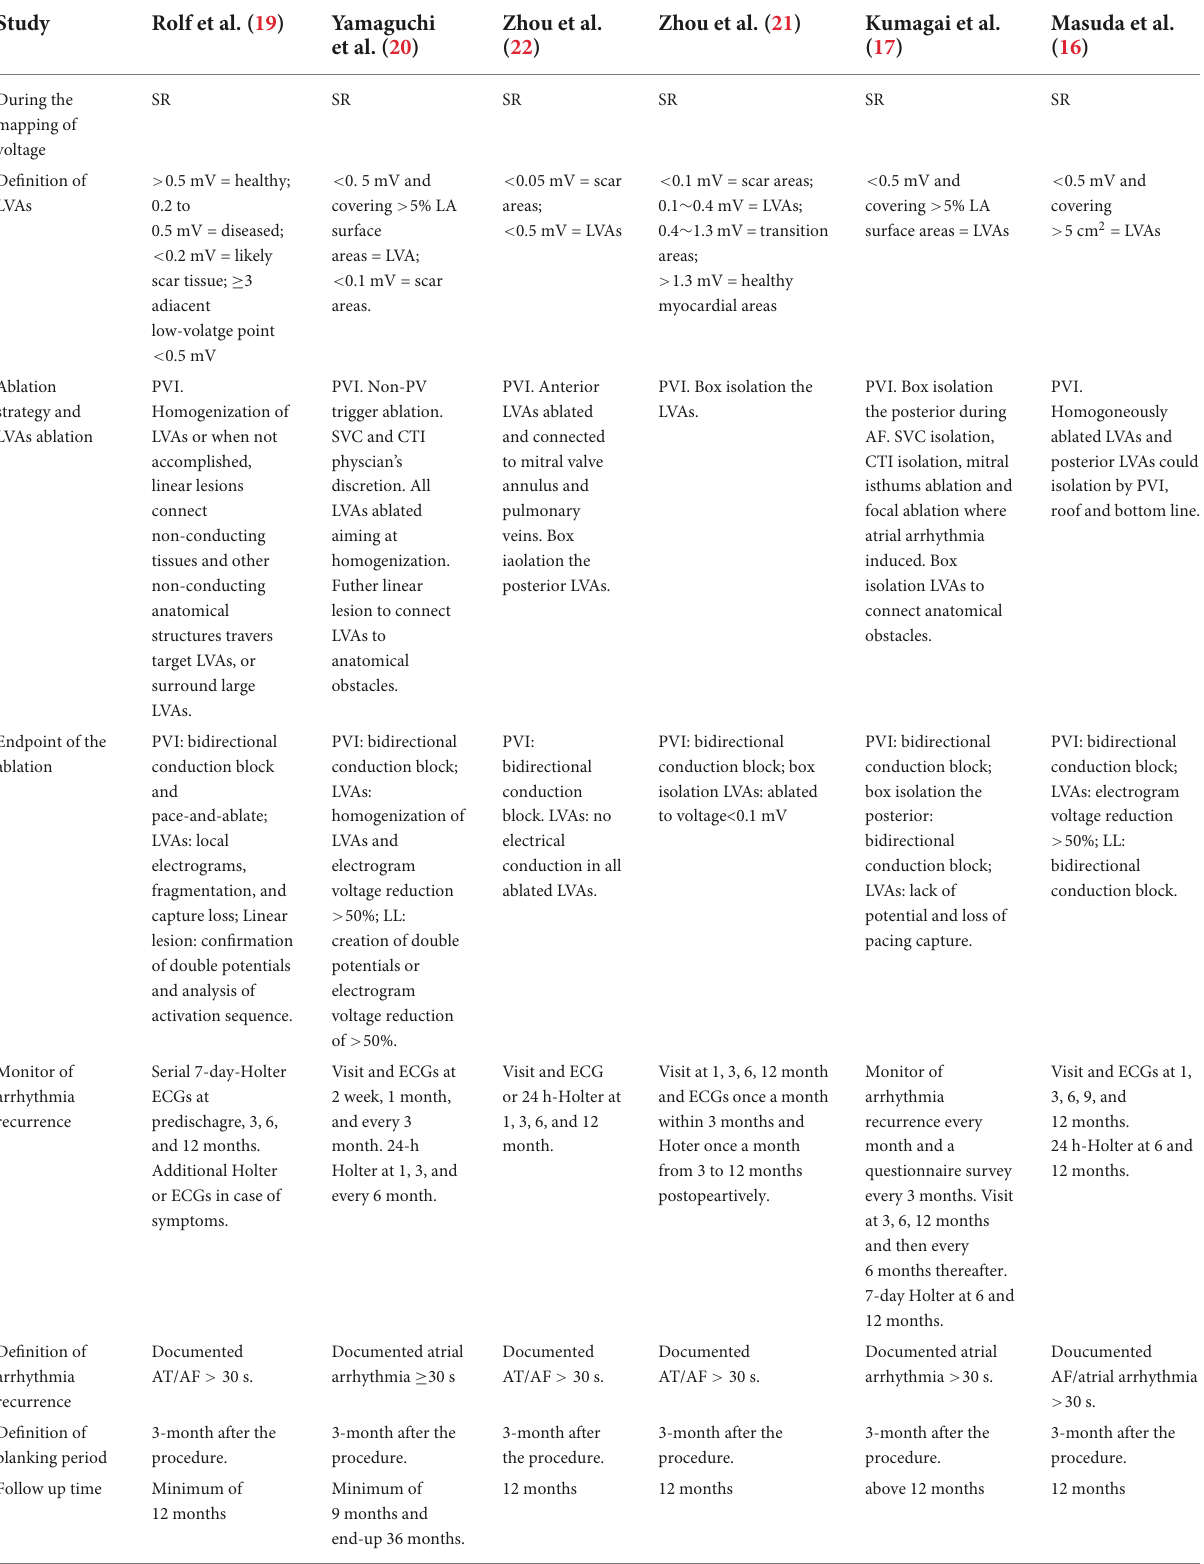
TABLE 2 Detailed procedures of included